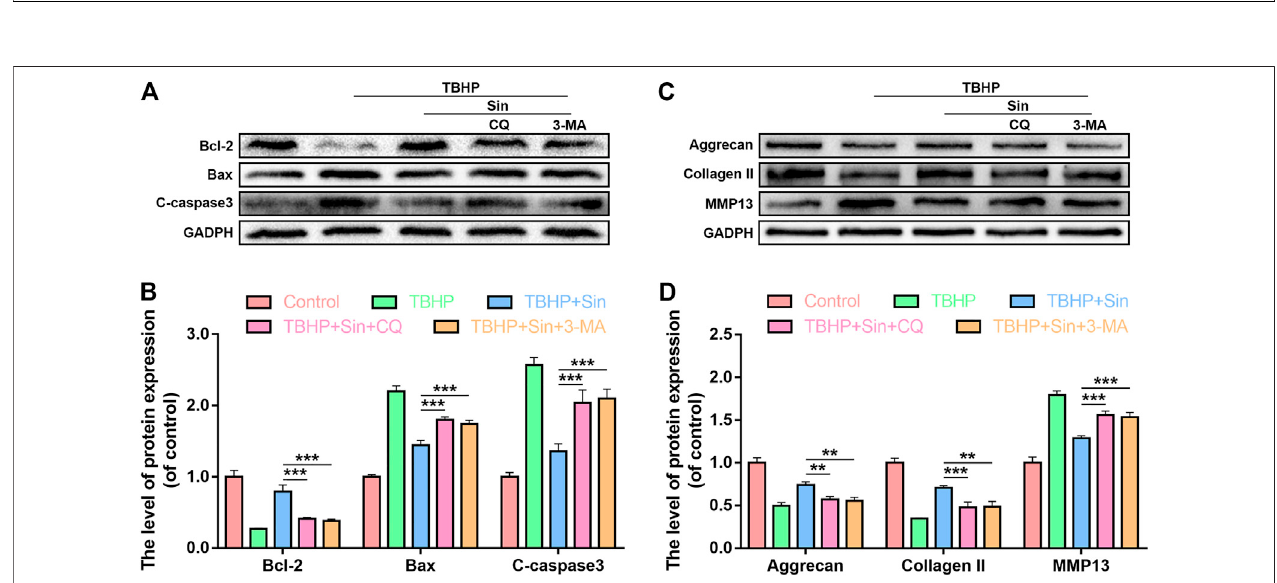
FIGURE 5 | Sin activates the AMPK/mTOR pathway in chondrocytes. (A, B) The results of dose-dependent western blotting show that the levels of p-mTOR and p-AMPKinchondrocytestreatedwithdifferentconcentrationsofSin(0,10,20,30,and40 μ M)for24 h. (C,D) Theresultsoftime-dependentwesternblottingshowthat the levels of p-mTOR and p-AMPK in chondrocytes treated with 40 μ M Sin for different times (0, 6, 12, 24,and 48 h). The data are presented as the means ± SD ( n (cid:1) 3); * p < 0.05, ** p < 0.01, and *** p < 0.001.